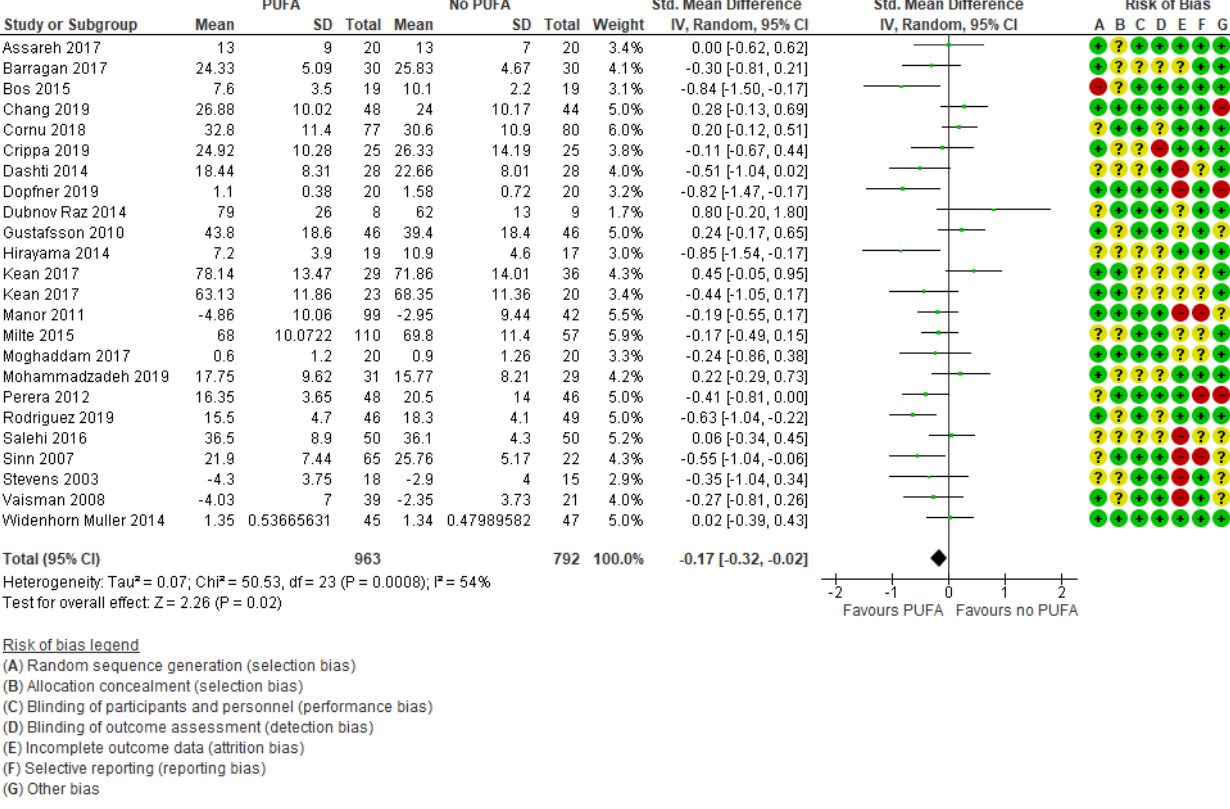
Figure 4. Forest plot of comparison: polyunsaturated fatty acids (PUFA) vs. placebo, outcome: teacher-reported core symp- toms (end of treatment). Green square indicates summary estimates of the individual studies. Black diamond indicates total summary effect estimate.